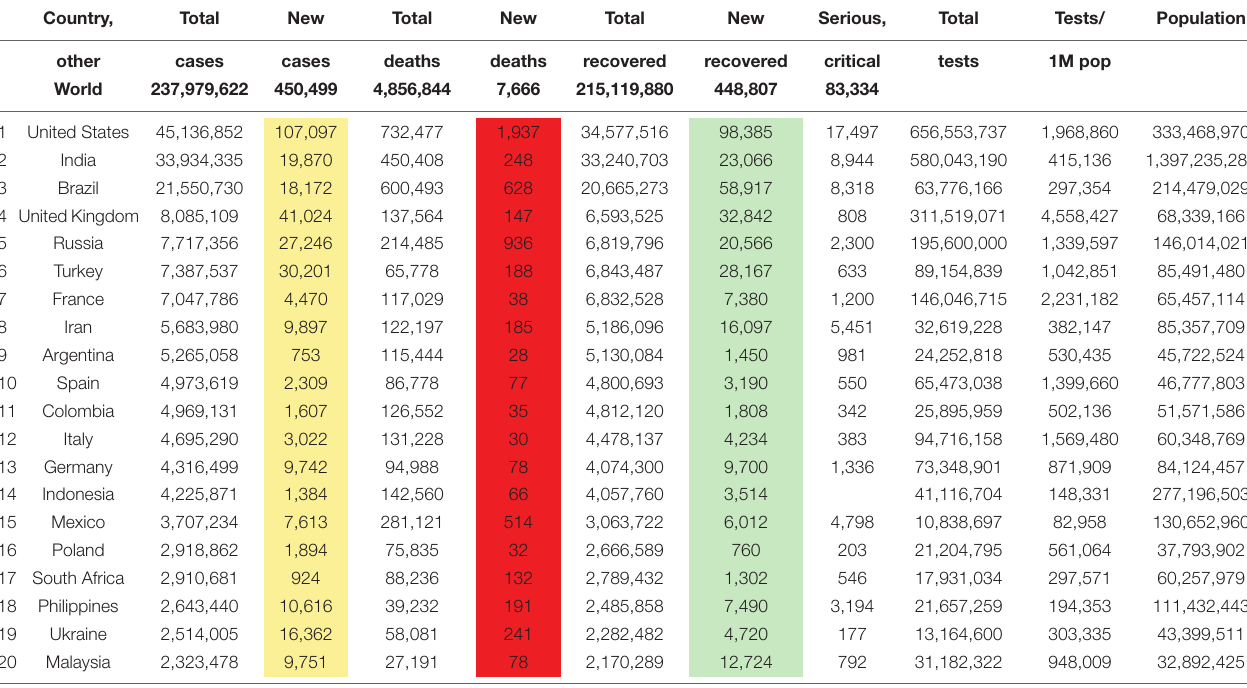
TABLE 4 | COVID-19 infected cases in top 20 countries worldwide, as of October 09, 2021.